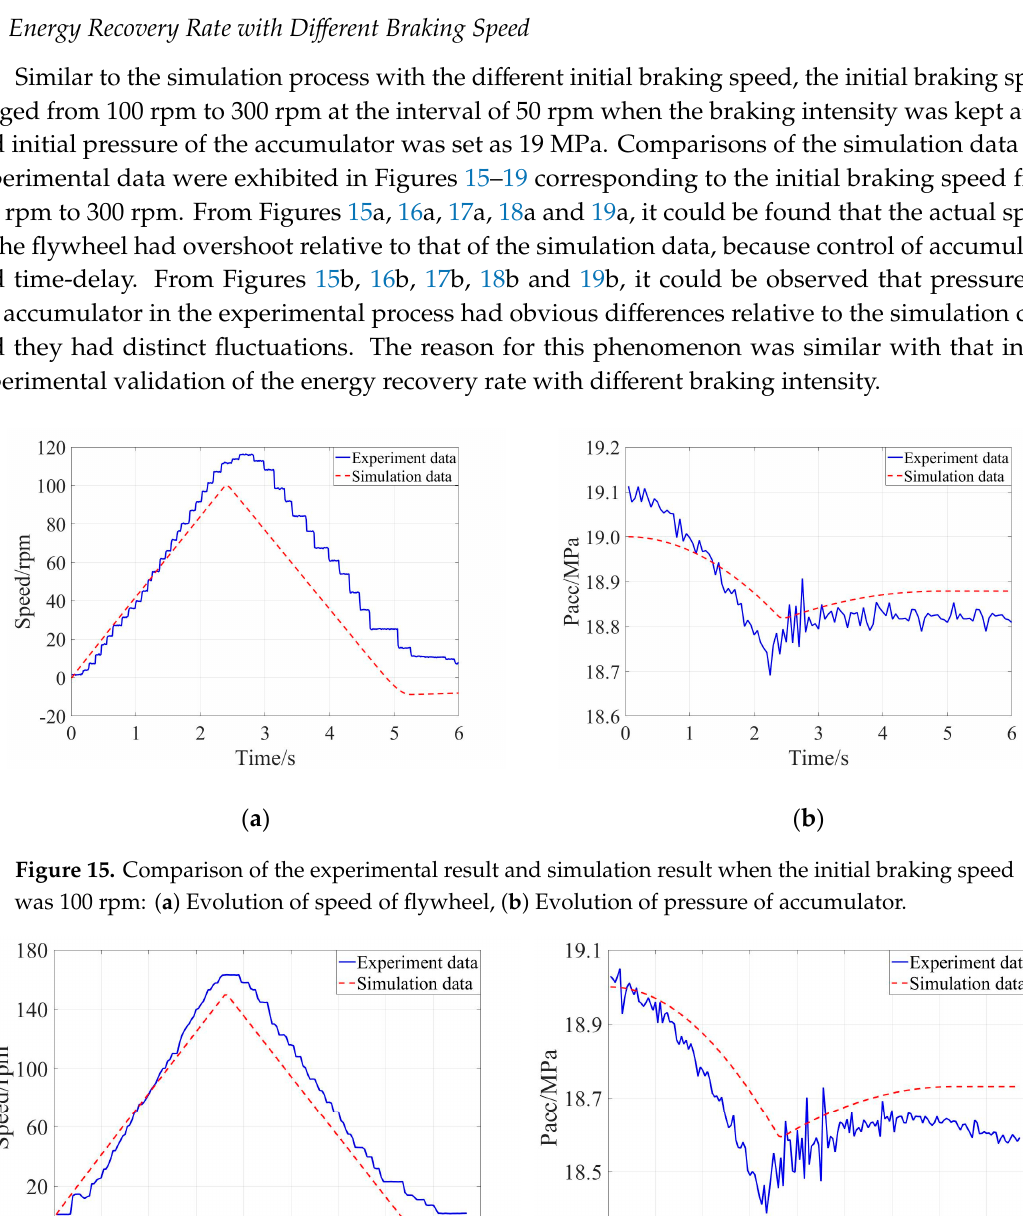
Figure 16. Comparison of the experimental result and simulation result when the initial braking speed was 150 rpm: ( a ) Evolution of speed of flywheel, ( b ) Evolution of pressure of accumulator.